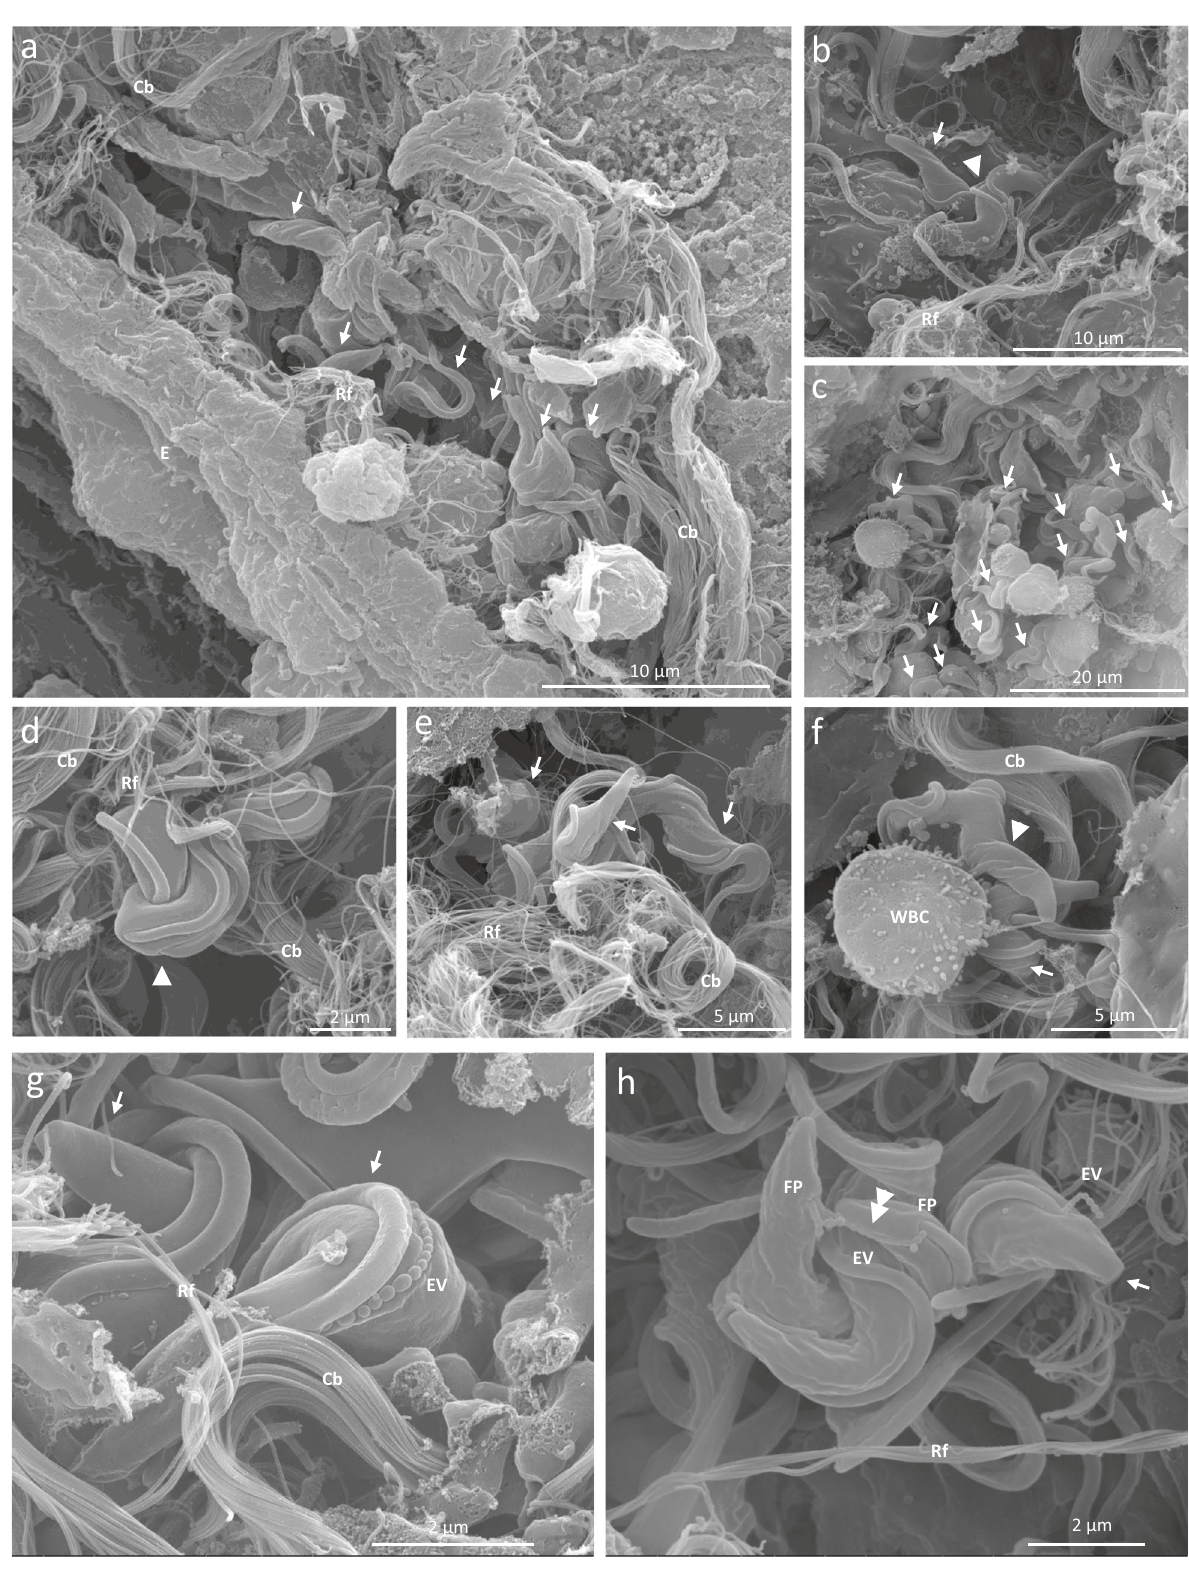
Fig. 2 | Scanning electron microscopic images of lung tissue of T. b. brucei infectedmice. GroupsofthreeC57BL/6JRjmicewereinfectedviathebiteofa T.b. brucei AnTar1infected G.morsitans tsetse fl y.Afterperfusionofthevascularsystem at 10 dpi, lungs were fi xed in glutaraldehyde and embedded in 1% agarose prior to vibratome sectioning. a – f Extravascular parasites embedded in lung tissue. g – h Examplesofextracellularvesiclesas “ beadsonastring ” .Cbcollagenbundle,Rf